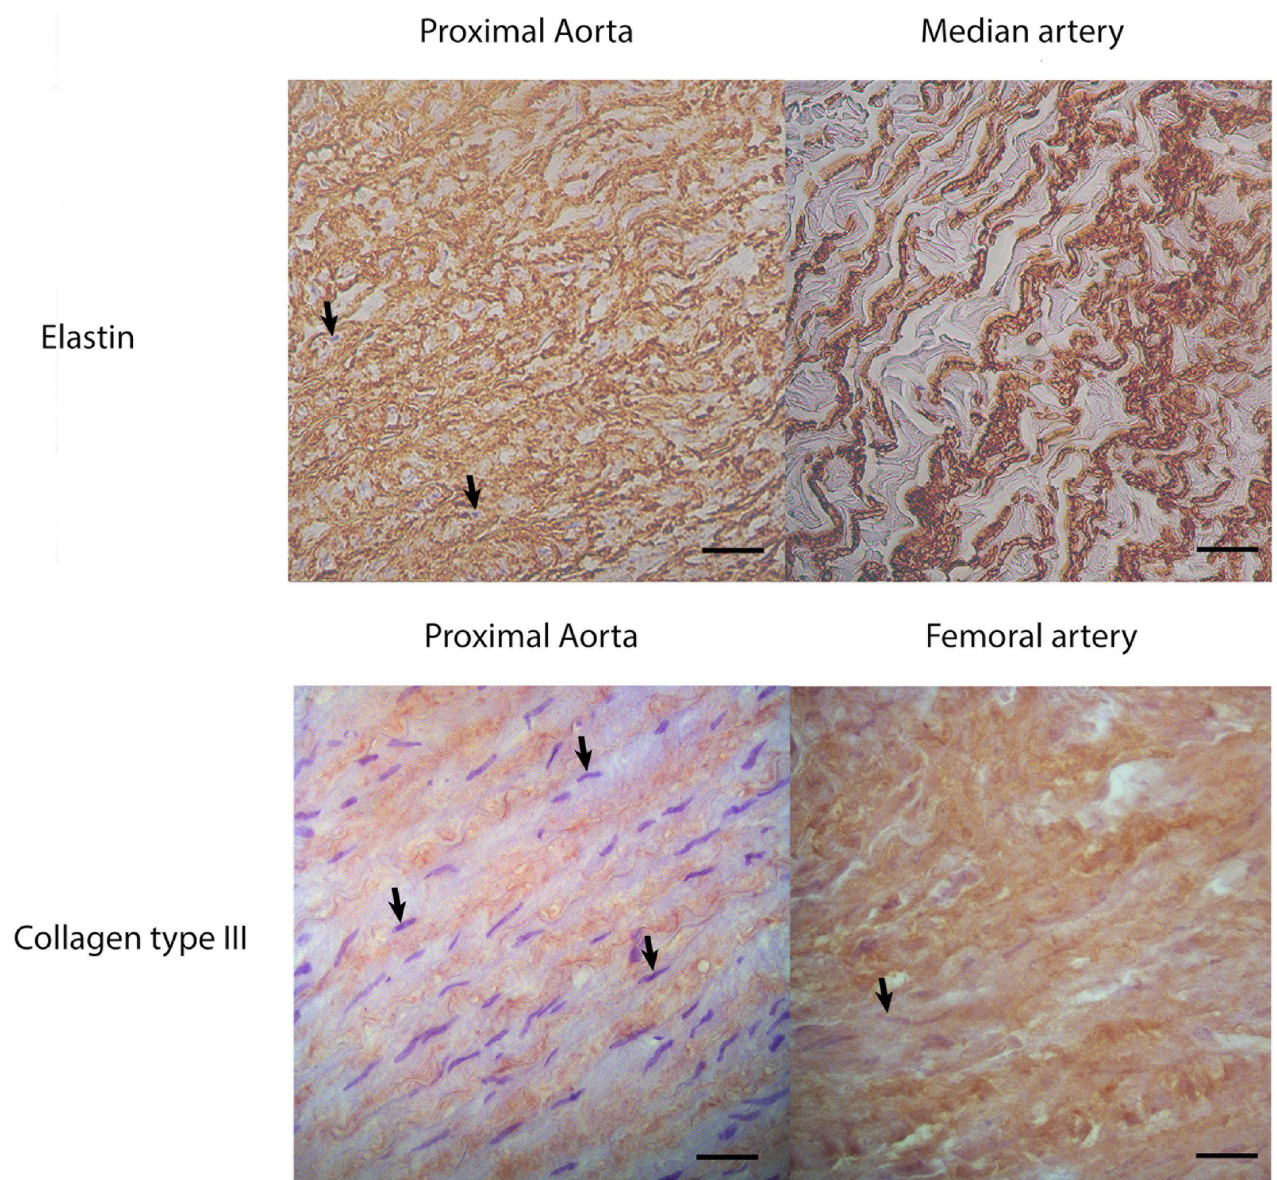
Fig 6. Immunohistochemistry for elastin and collagen type III (brown) of longitudinal sections through the vessel wall. The proximal aorta contains a higher area % of elastin and a lower area % of collagen type III compared to peripheral arteries. Magnification x400; bar = 250 μ m. Black arrows indicate nuclei of